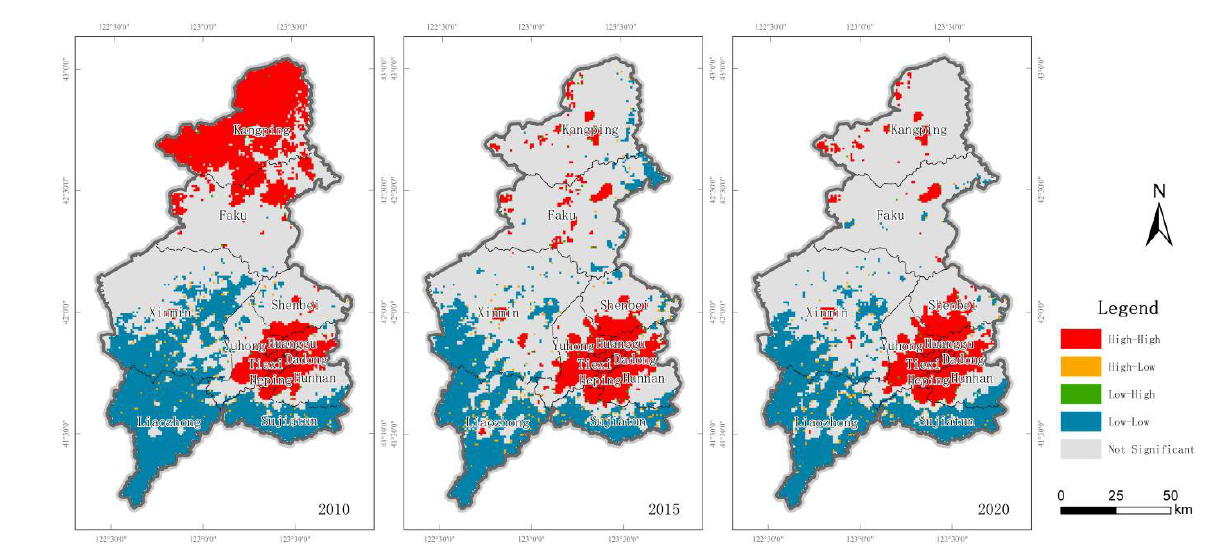
Figure 5. LISA diagram of ecological vulnerability index in Shenyang in 2010, 2015 and 2020.